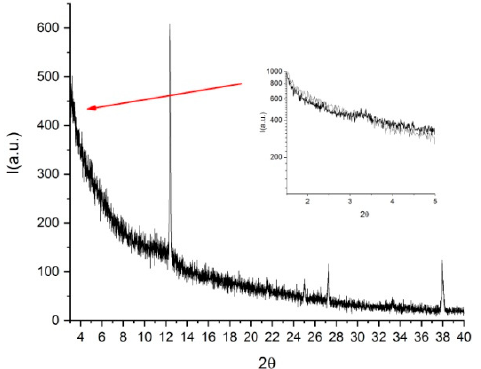
Figure 16. XRD pattern of pure DSCG doped with trans-Hyp. Reprinted from [49].